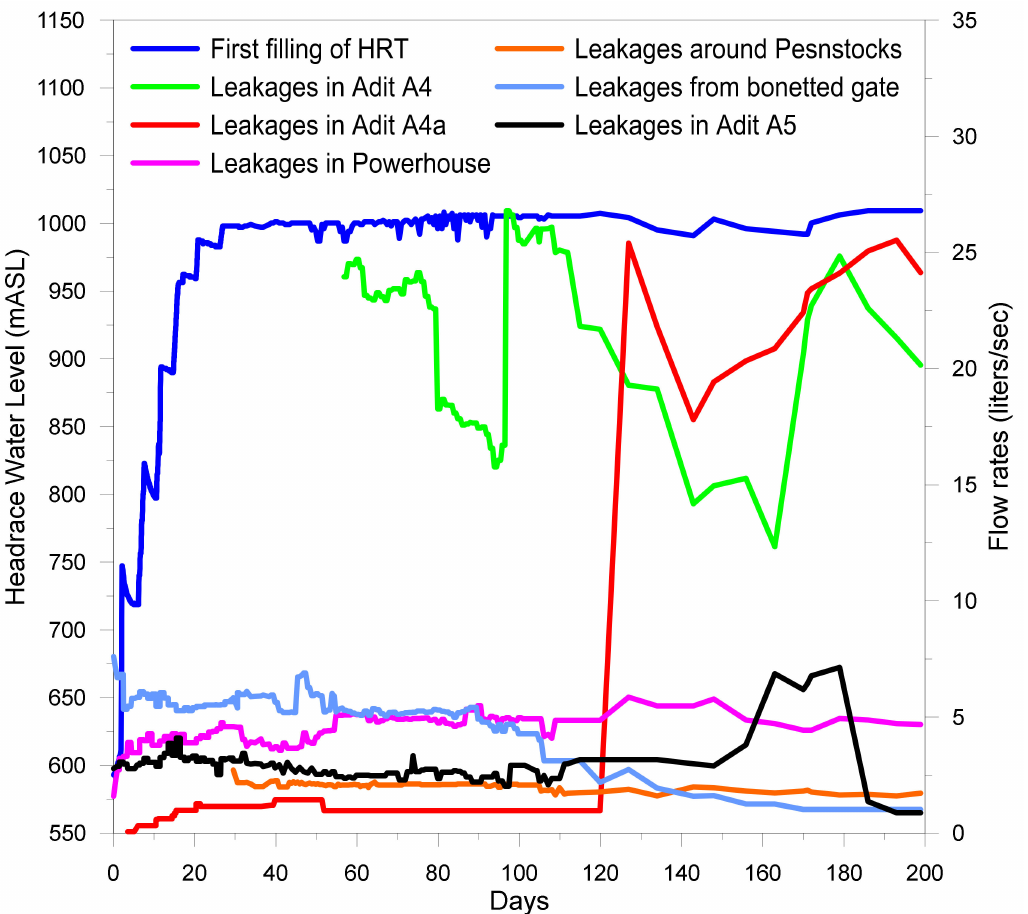
Figure 13. Filling of the headrace tunnel and subsequent infiltration into the adits, drainage gallery, and